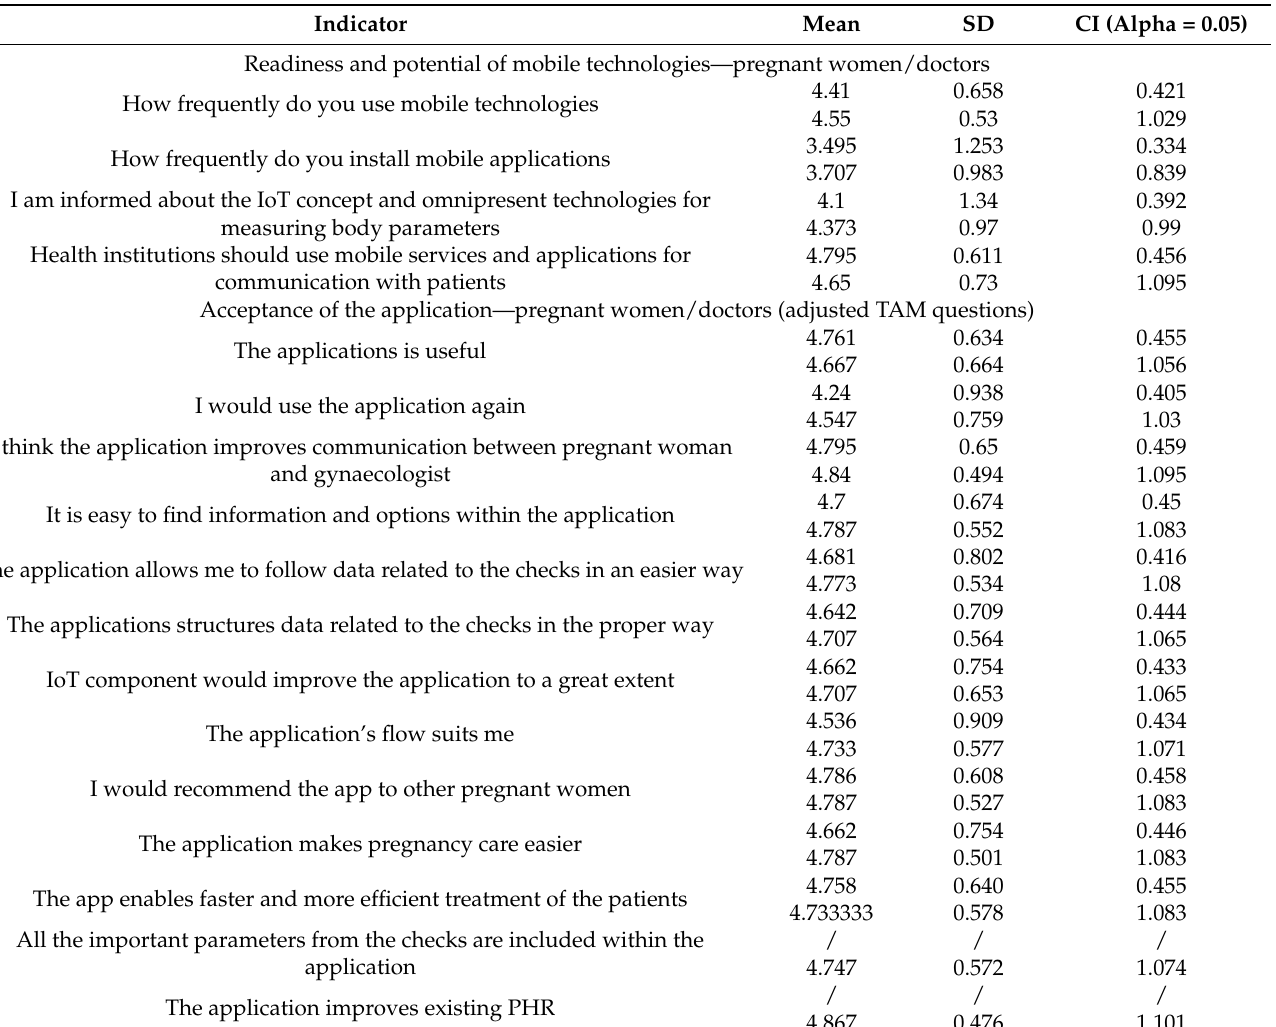
Table 2. Results of the